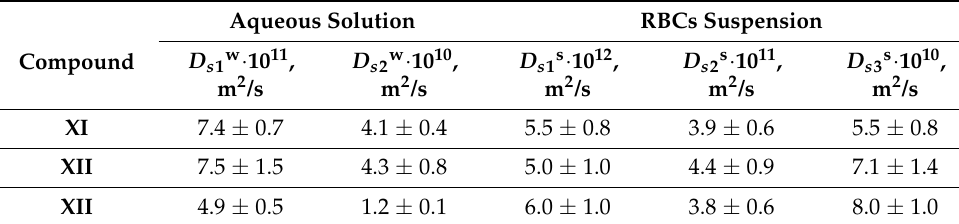
Table 5. Self-diffusion coefficients of WSFD molecules in aqueous solutions and RBCs suspension. D s 1w and D s 2w —aqueous solution ; D s 1s , D s 2s , D s 3s —RBCs suspension. Reprinted with permission